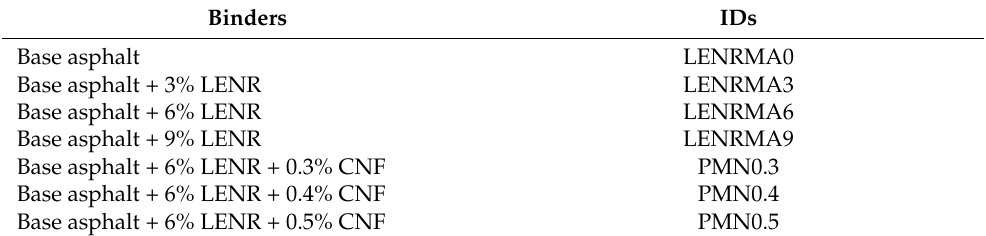
Table 2. Properties of the base asphalt, LENR polymer, and